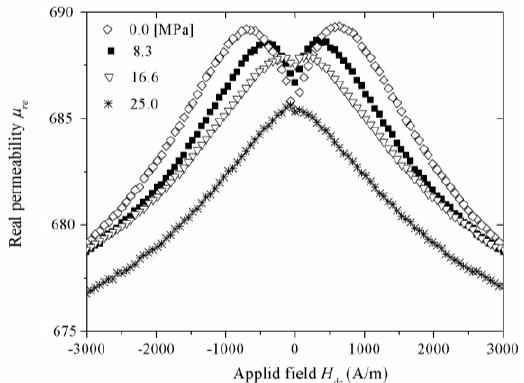
Figure 4.  (H ) curves under the effect of variable tension stress  for the re dc Fe Co Nb B 52 10 8 30